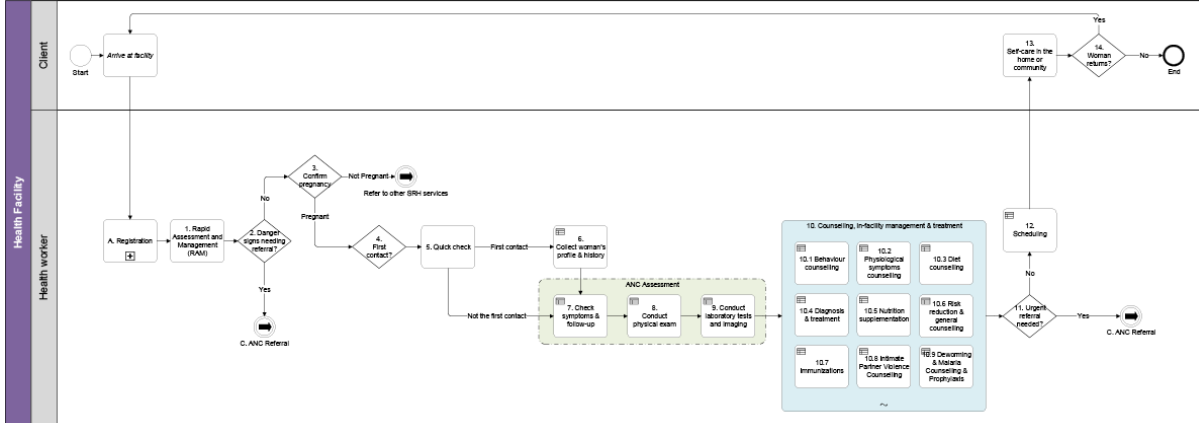
Figure 1. The antenatal care (ANC) contact business process. ANC: Antenatal care, SRH: sexual and reproductive